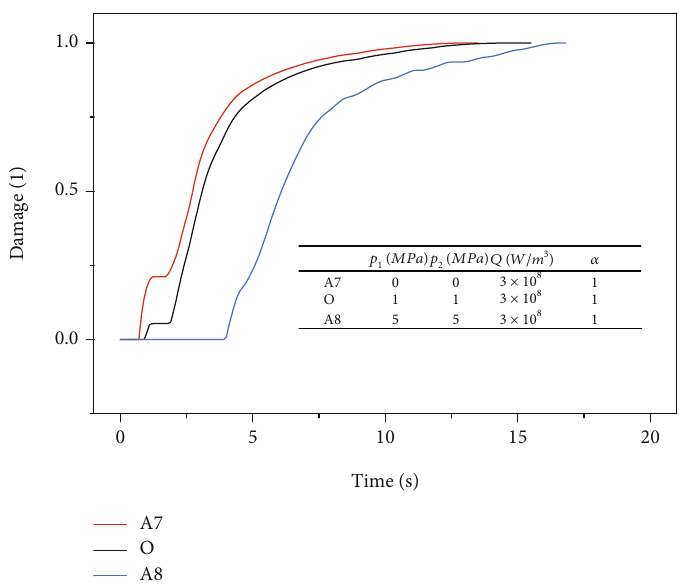
Figure 7: Maximum damage evolution curves under di ff erent bilateral loads.